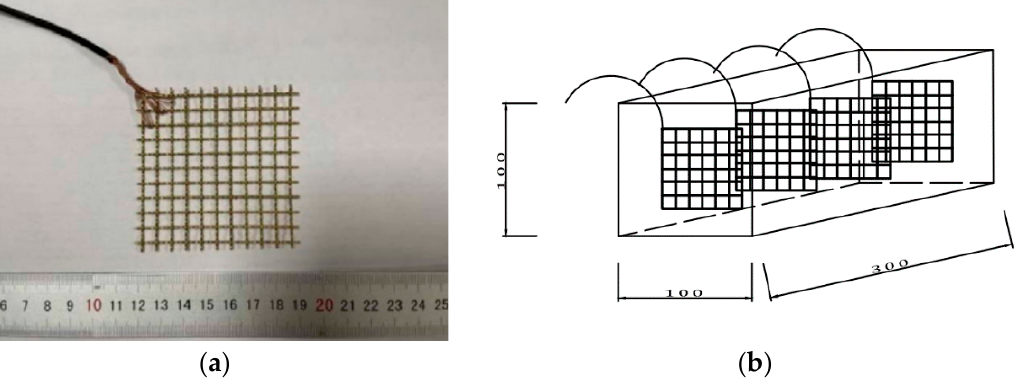
Figure 3. Dimensional parameters of specimen and electrode: ( a ) size of copper mesh; ( b ) size of specimen.